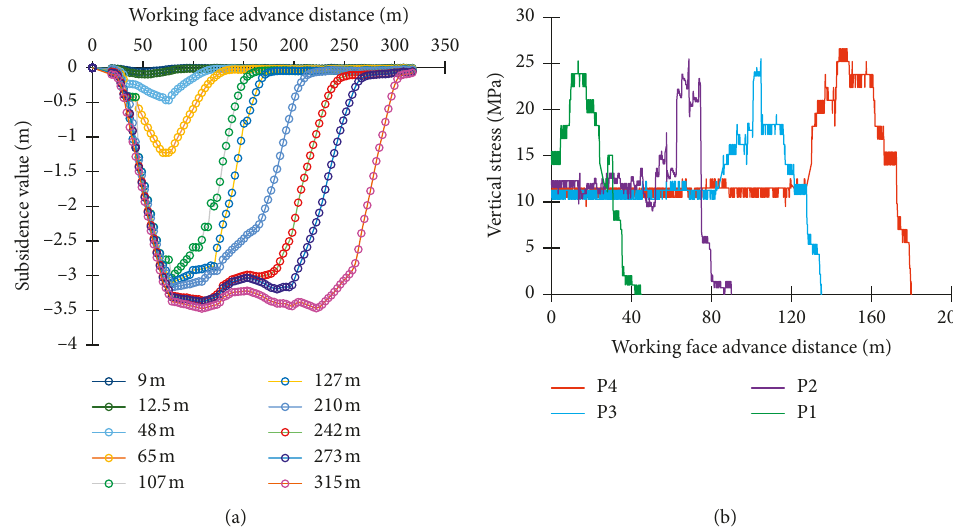
Figure 11: Characteristics of overburden movement. (a) Curves of main roof subsidence. (b) Pressure curves.